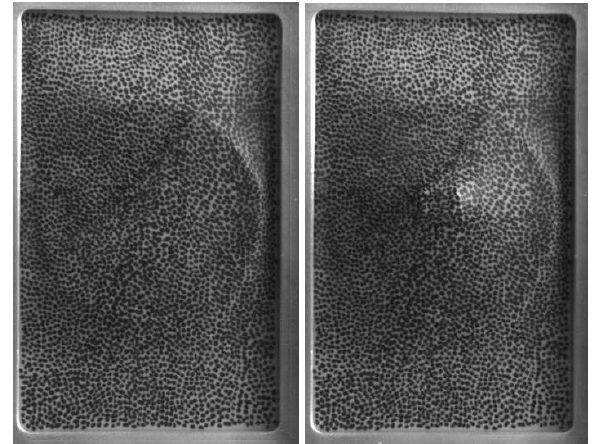
Figure 6. Image sections of membrane in epoch 0 and epoch 15